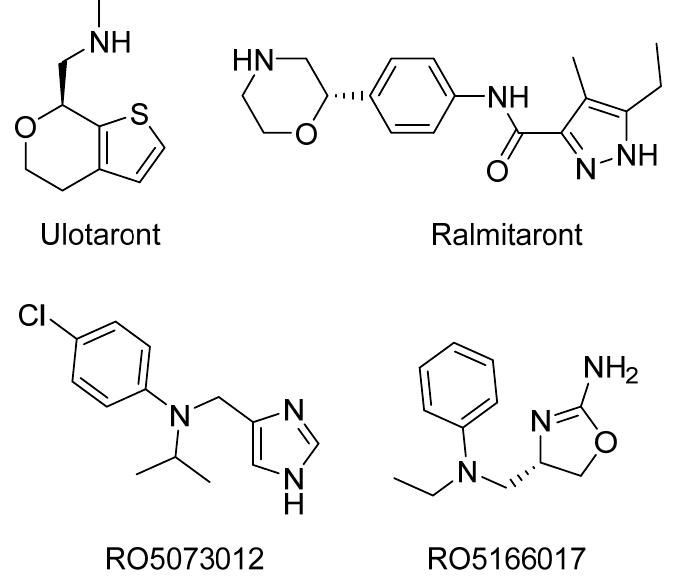
Figure 1. Advanced TAAR1 agonists at various stages of investigation: Ulotaront (phase III clinical trials), Ralmitaront (phase II clinical trials), RO5073012 (preclinical investigation), and RO5166017 (preclinical investigation).